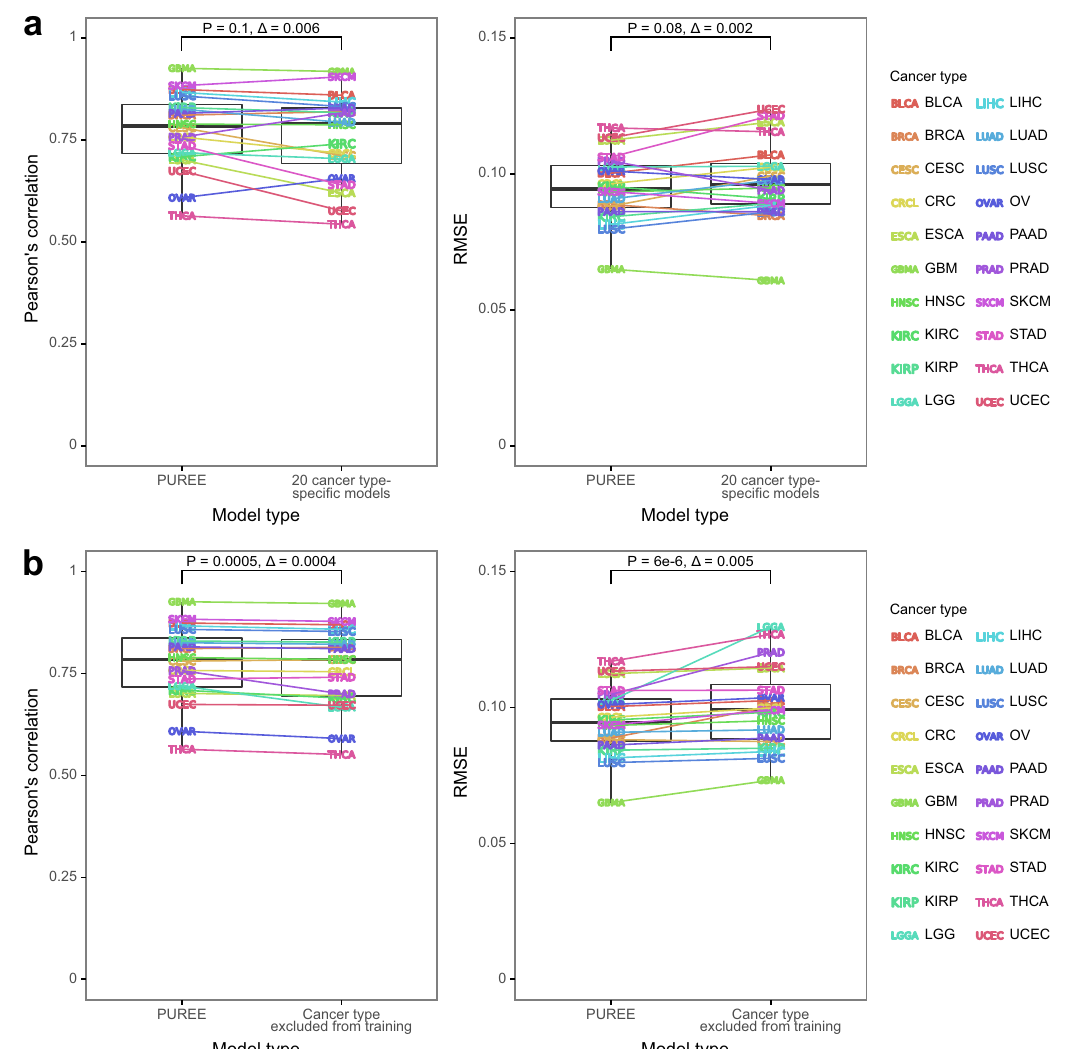
Fig. 3 PUREE versus cancer type-speci fi c architectures and unseen cancer types. a Performance (Pearson ’ s correlation and RMSE) of PUREE as compared to 20 cancer-type-speci fi c models on the test split of the TCGA dataset. b Performance (Pearson ’ s correlation and RMSE) of PUREE when predicting on a cancer type included in training data versus when the same cancer type was excluded from the training data. In the boxplots, the lower and upper hinges correspond to the fi rst and third quartiles, the upper whisker extends to the largest value no further than 1.5 of inter-quartile range from the hinge, the lower whisker extends to the smallest value no further than 1.5 of inter-quartile range from the hinge, and points beyond the end of the whiskers are plotted individually. Differences were evaluated with the Wilcoxon signed-rank test (two-tailed), and delta is the difference between medians of metrics across all cancer types. P-values from Wilcoxon signed-rank test (two-tailed)